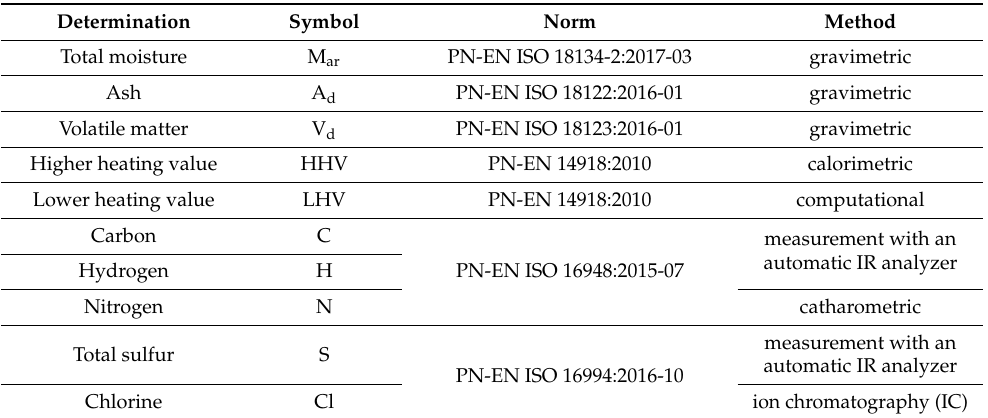
Table 1. Methods of studying the energy